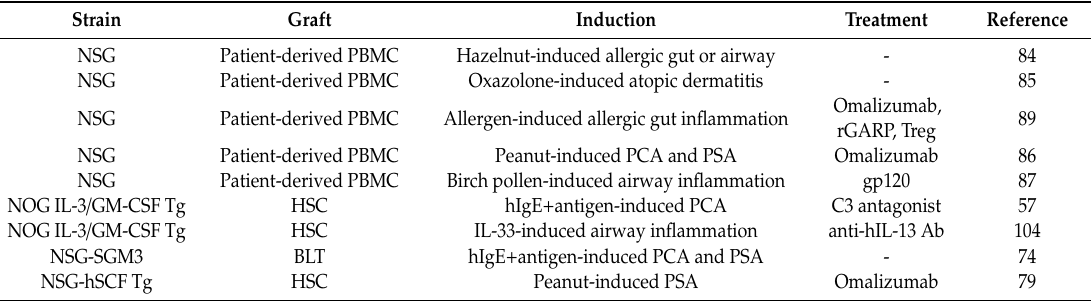
Table 2. Human allergy humanized mouse